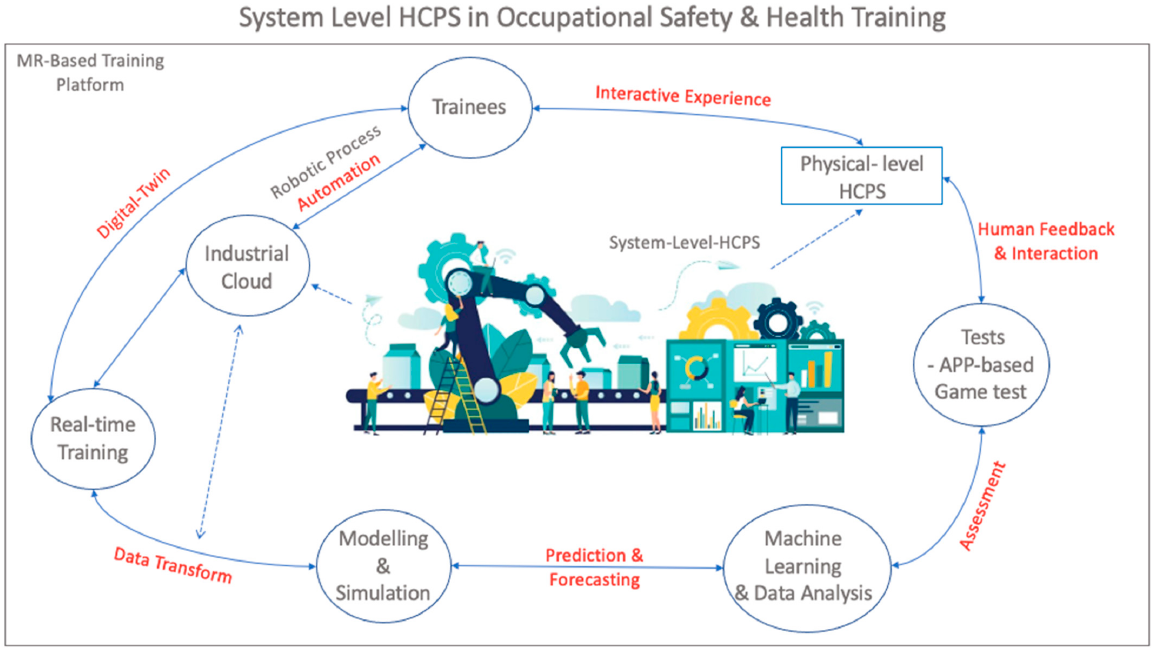
Figure 2. System Level of human–cyber–physical system in occupational safety and health training.